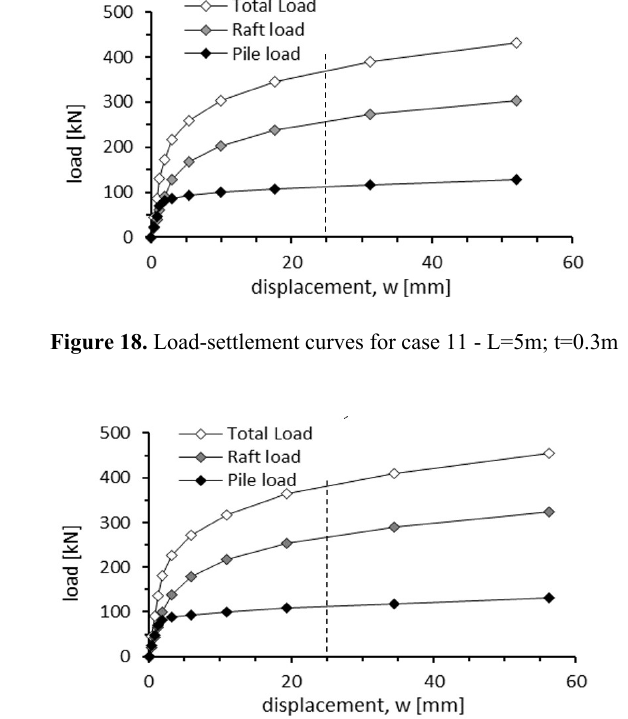
Figure 19. Load-settlement curves for case 12 - L=5m; t=0.4m